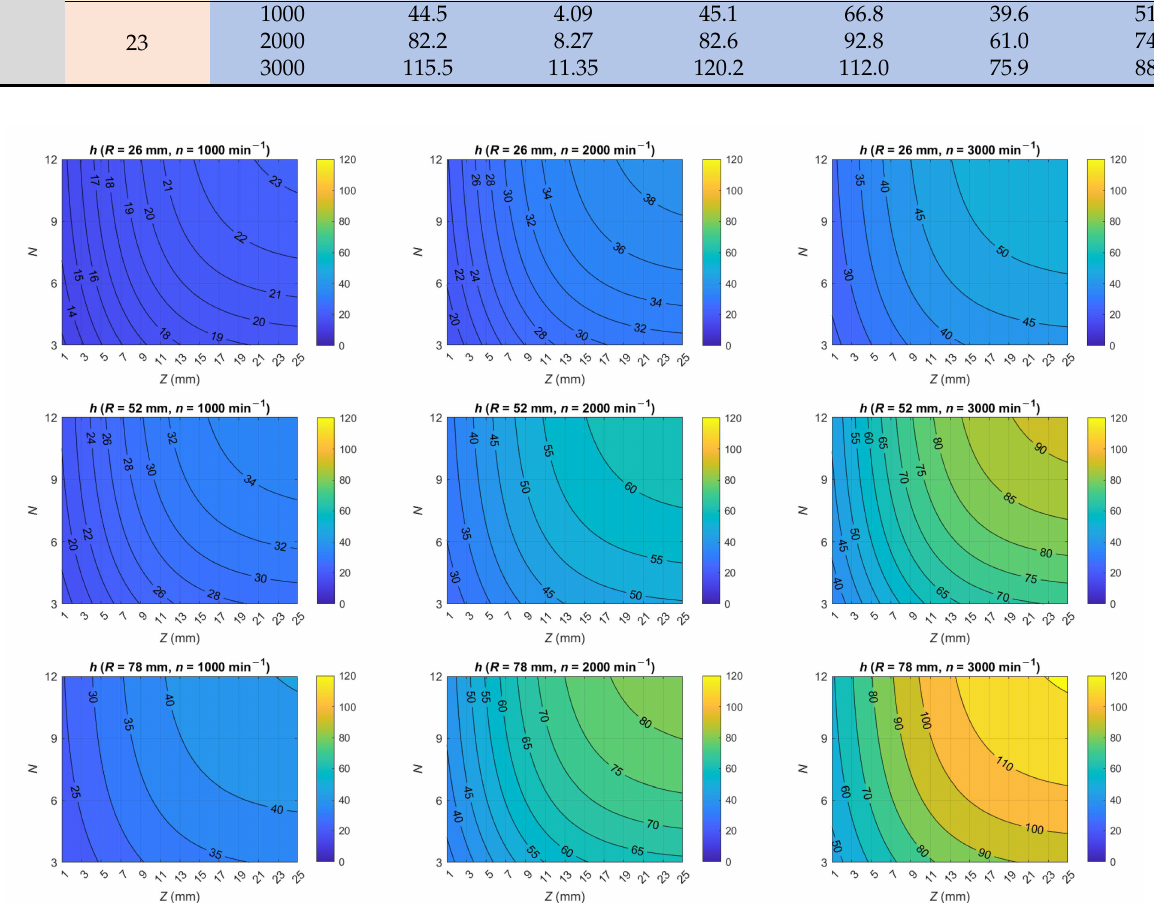
Figure 15. Value of HTC h (in (W/m 2 K)), calculated by analytical model (13), for different rotor radii, rotational speeds, number of blades, and blade